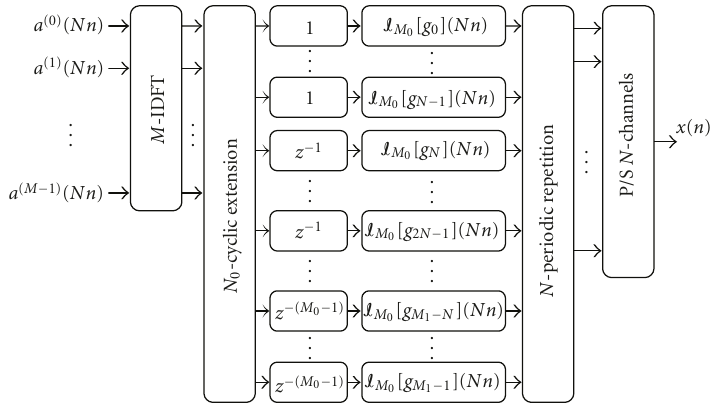
Figure 4: Synthesis bank (method B).